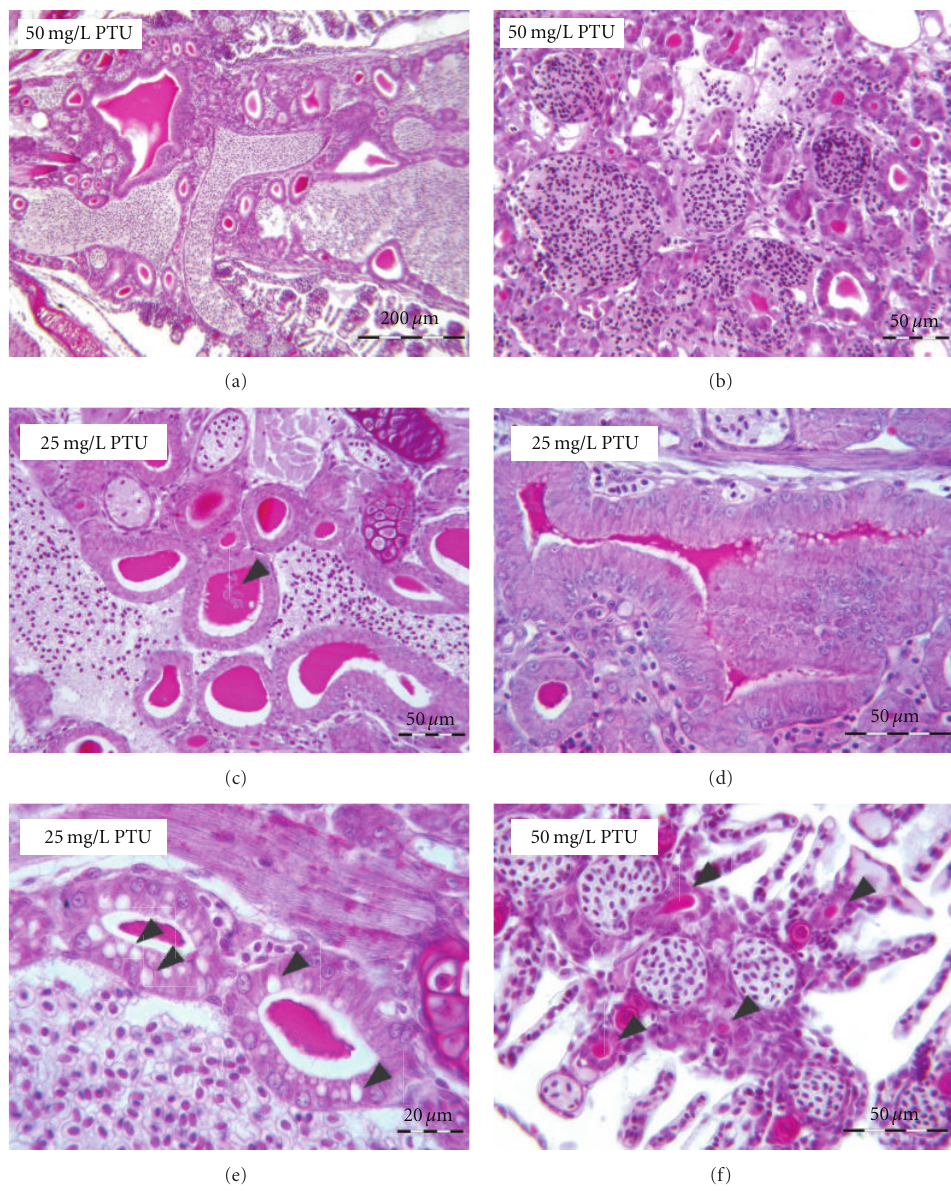
Figure 6: Representative histopathological e ff ects in thyroidal tissue of zebrafish ( Danio rerio ) exposed to 25 and 50 mg/L PTU. Exposure to PTU resulted in massive hyperplasia and hyperemia with an increased number of small follicles embedded in adjacent blood capillaries (a, b). In the 25 and 50 mg/L concentration groups, inclusion bodies in the colloid were visible ((c): (cid:2) ). At concentrations ≥ 10 mg/L, severe hypertrophy of thyroid follicles could be detected with stratification and cell crowding (d): One individual in each of the 25 and 50mg/L concentration groups showed mostly apically located vesicles in the epithelial cells ((e): (cid:2) ). Some individuals displayed small follicles scattered across the gills ((f): (cid:2) ). Sections of 2 μ m thickness stained with periodic acid-Schi ff (PAS) and Mayer’s